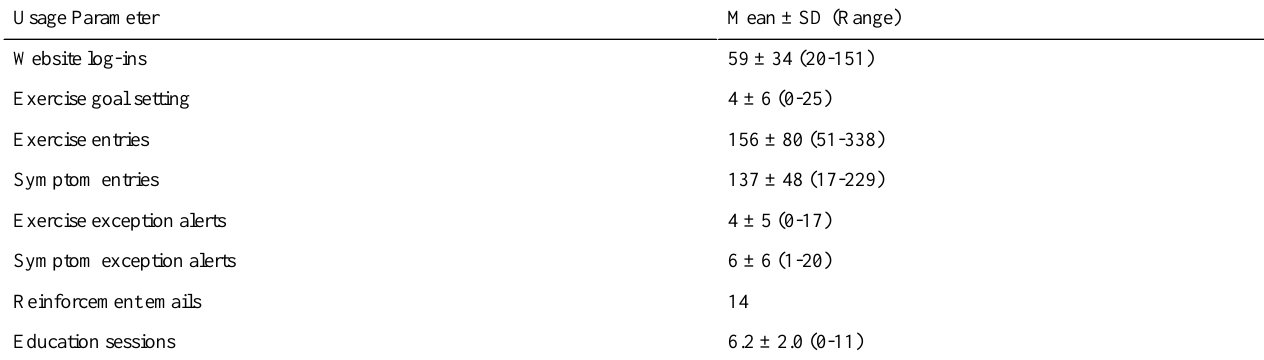
Table 5. Usage statistics over 6 months for eDSMP